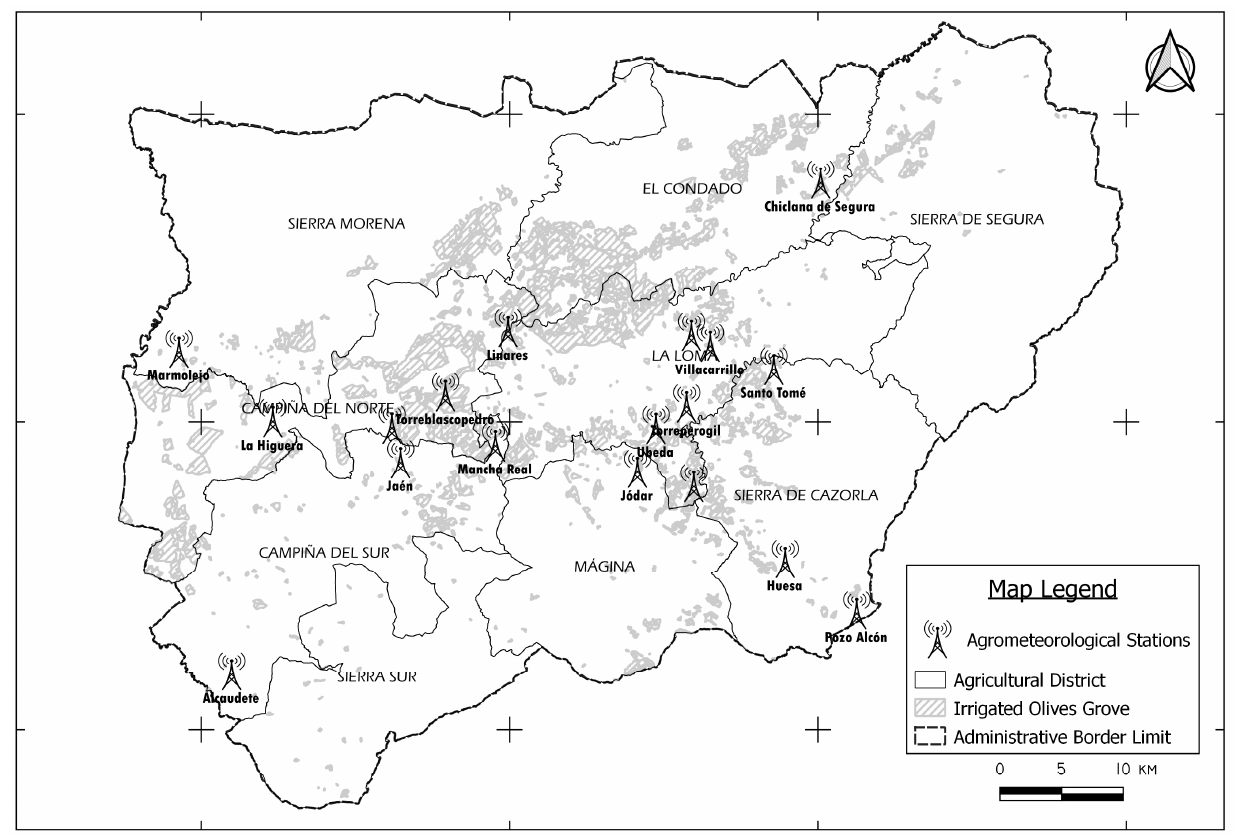
Figure 1. Study area with indication of irrigated olive groves and location of agroclimatic stations.